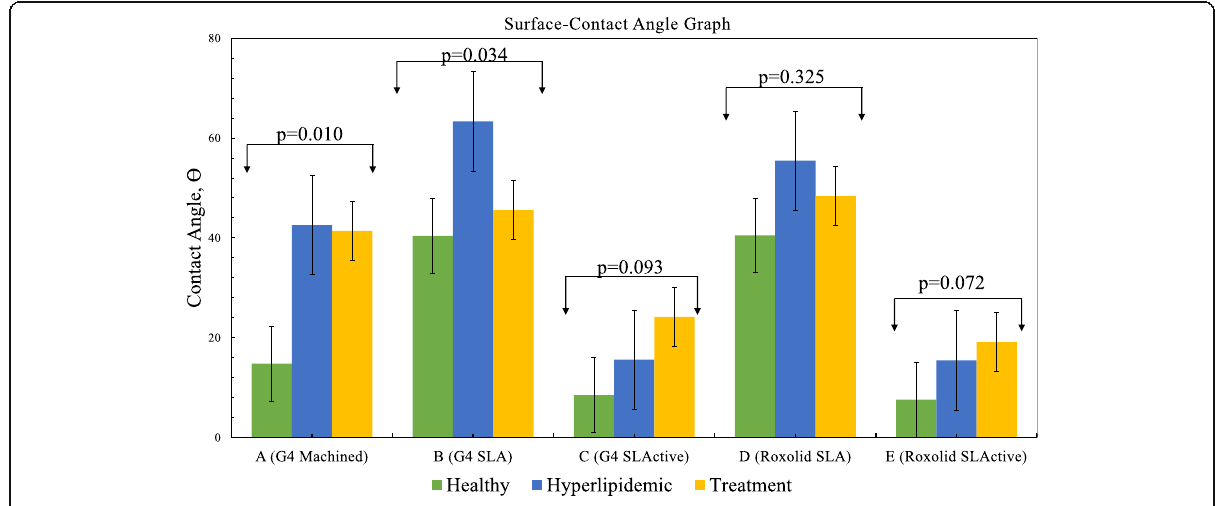
Fig. 5 Contact angles at different titanium surfaces for different treatment periods